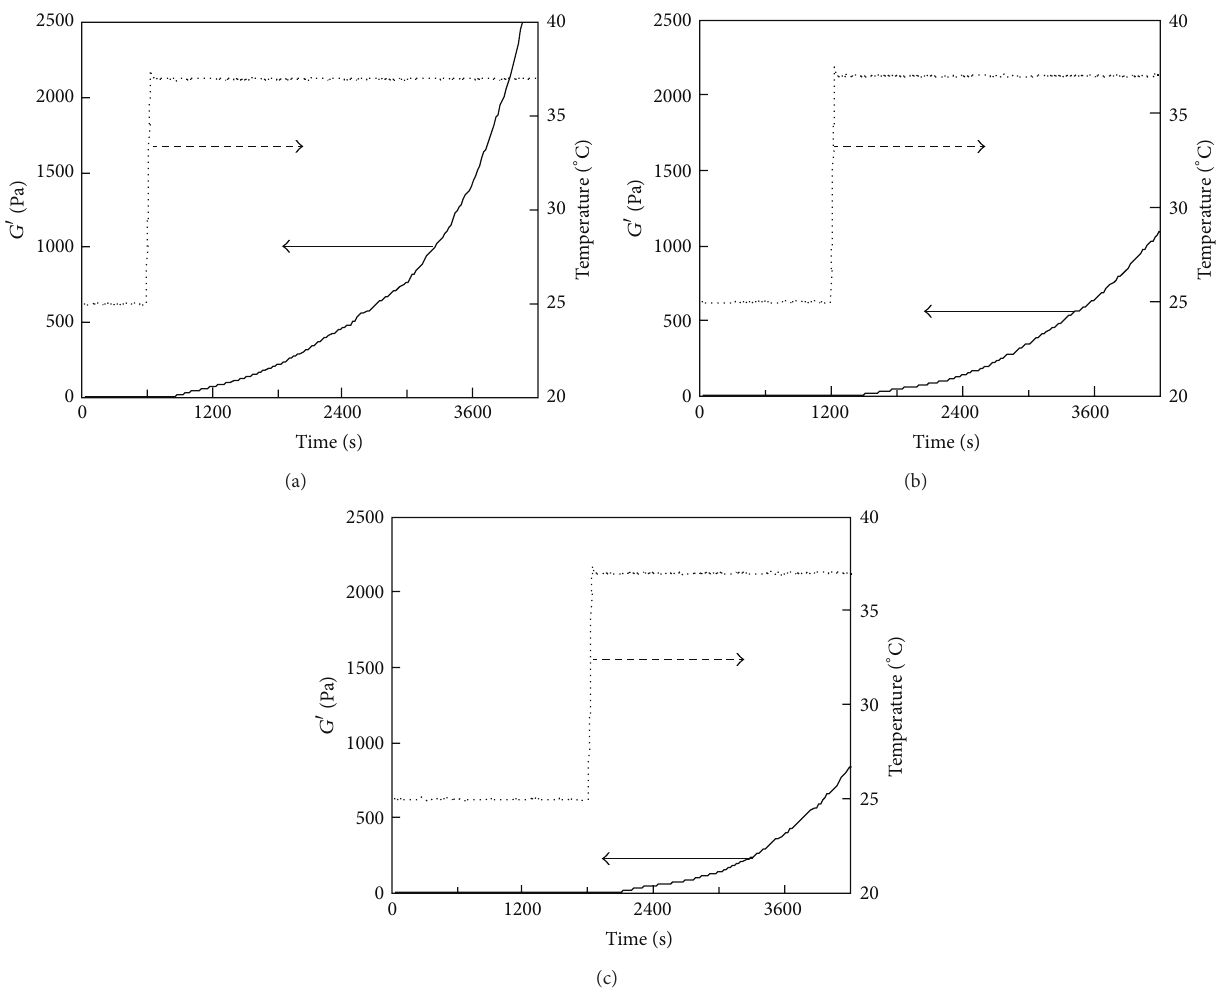
Figure 4: Storage modulus ( G 󸀠 ) of the 0.5% PSC/1mM genipin solution measured by a temperature-responsive gelation test. The temperature was maintained at 25 ∘ C for (a) 600, (b) 1200, and (c) 1800s and then increased to 37 ∘